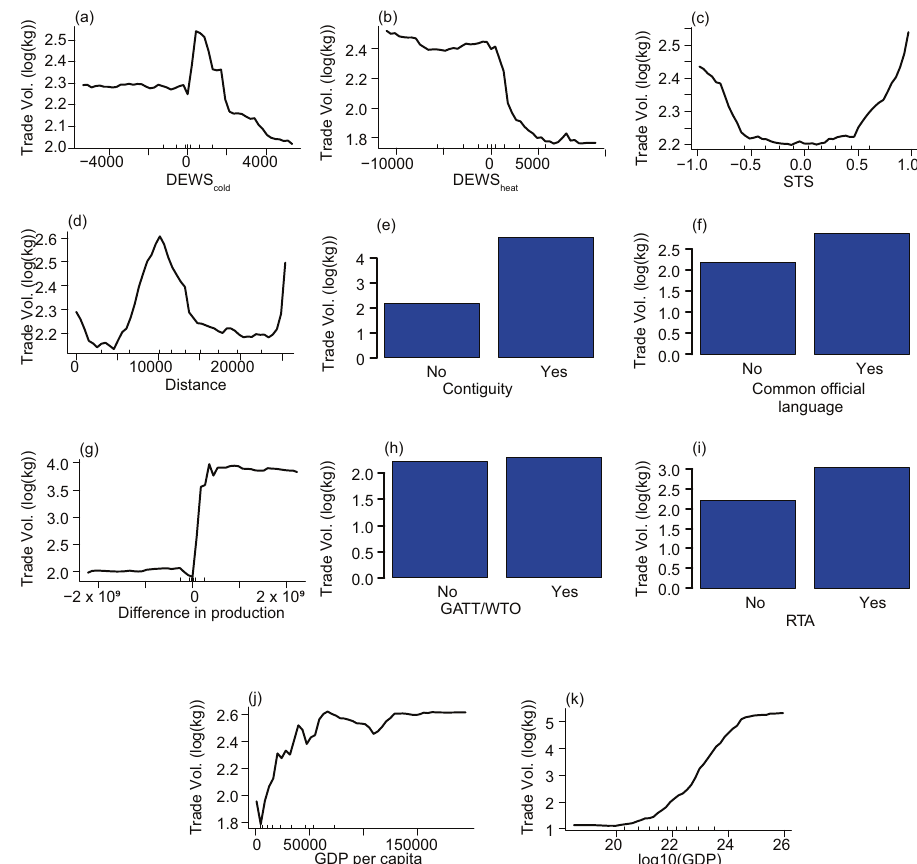
Fig. 2 Random forest partial dependence plots for trade volume in 2005 – 2014. The x-axes represent the considered covariates: ( a ) difference in extreme cold stress (DEWS cold ), ( b ) difference in extreme heat stress (DEWS heat ), ( c ) short-term synchrony (STS), ( d ) distance, ( e ) contiguity, ( f ) common of fi cial language, ( g ) difference in production, ( h ) The General Agreement on Tariffs and Trade (GATT)/ World Trade Organization (WTO), ( i ) Regional Trade Agreements (RTA), ( j ) gross domestic product (GDP) per capita, and ( k ) GDP. The inner tickmarks on the x-axes represent deciles of the variables. The y-axis represents the marginal effect of the covariate on wheat trade volume. The blue bars show marginal effects caused by categorical covariates, while black lines show marginal effects of continuous